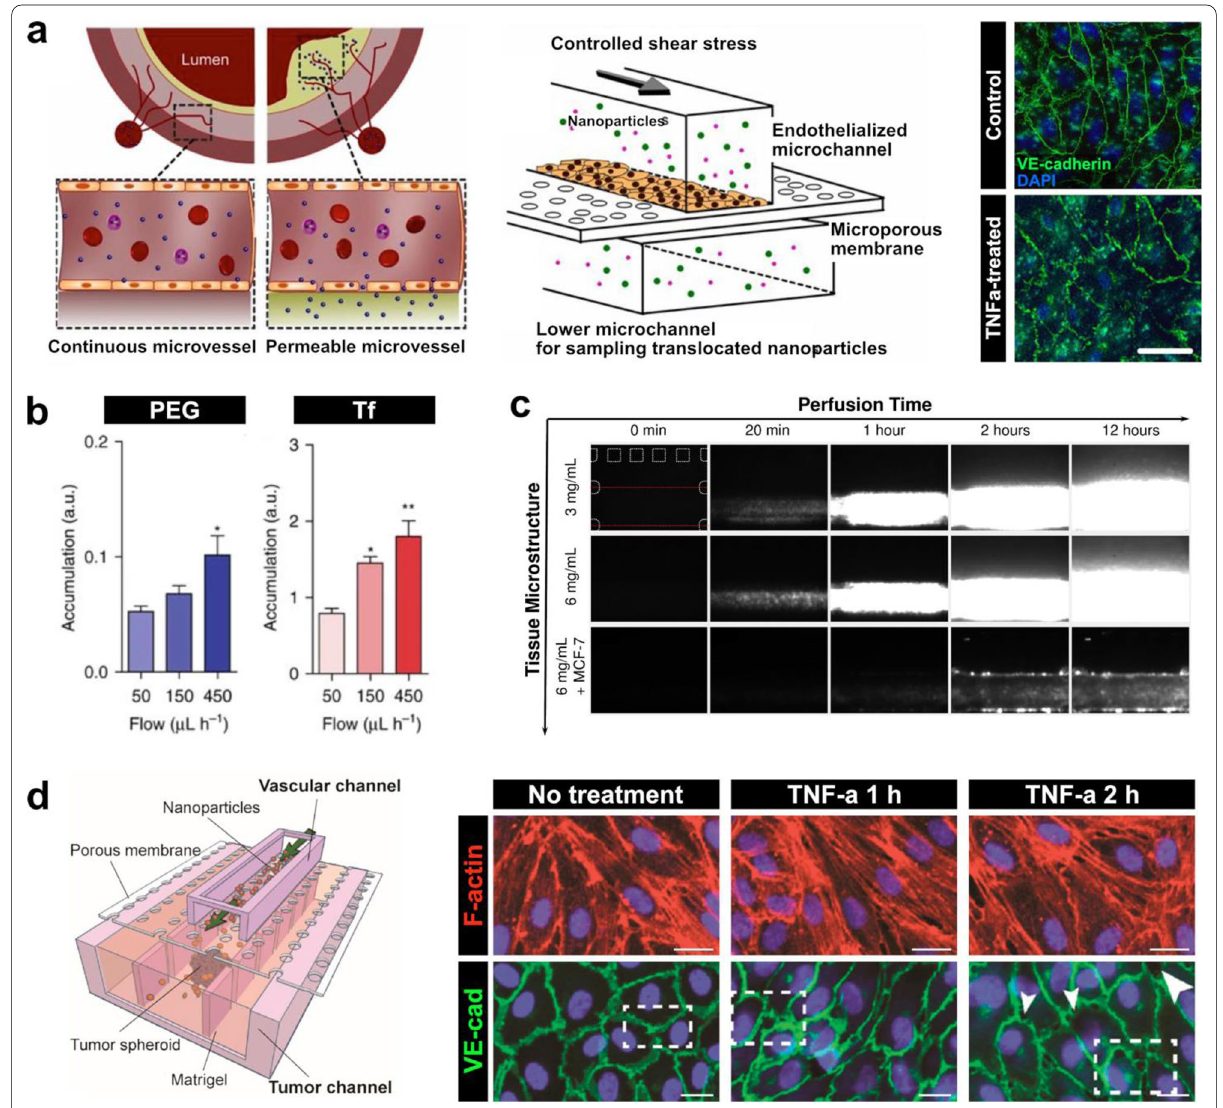
Fig. 3 Effect of microenvironmental cues on nanoparticle delivery. a An atherosclerosis model to assess the shear and inflammatory effects on membrane permeability. Membrane permeability increases with tumor necrosis factor alpha (TNF- ɑ ) treatment and shear stresses, which results in increased nanoparticle translocation. Scale bar, 20 µm. b When PEGylated (PEG) and transferrin-functionalized (Tf) nanoparticles were flowed across a tumor-on-a-chip model (Fig. 2b), accumulation in tumor spheroid interstitial spaces doubled at a flow rate of 450 µl/h compared to a lower rate of 50 µl/h. c In the breast cancer tumor model (Fig. 2a), higher collagen concentrations did not affect nanoparticle translocation alone, but translocation increased under high collagen and cell packing. d A tumor-vasculature-on-a-chip platform was developed to model the effect of leaky vasculature near tumor sites. TNF- ɑ treatment increased intercellular gaps between endothelial cells (white arrows), mimicking leaky vasculature in vitro. Scale bars, 20